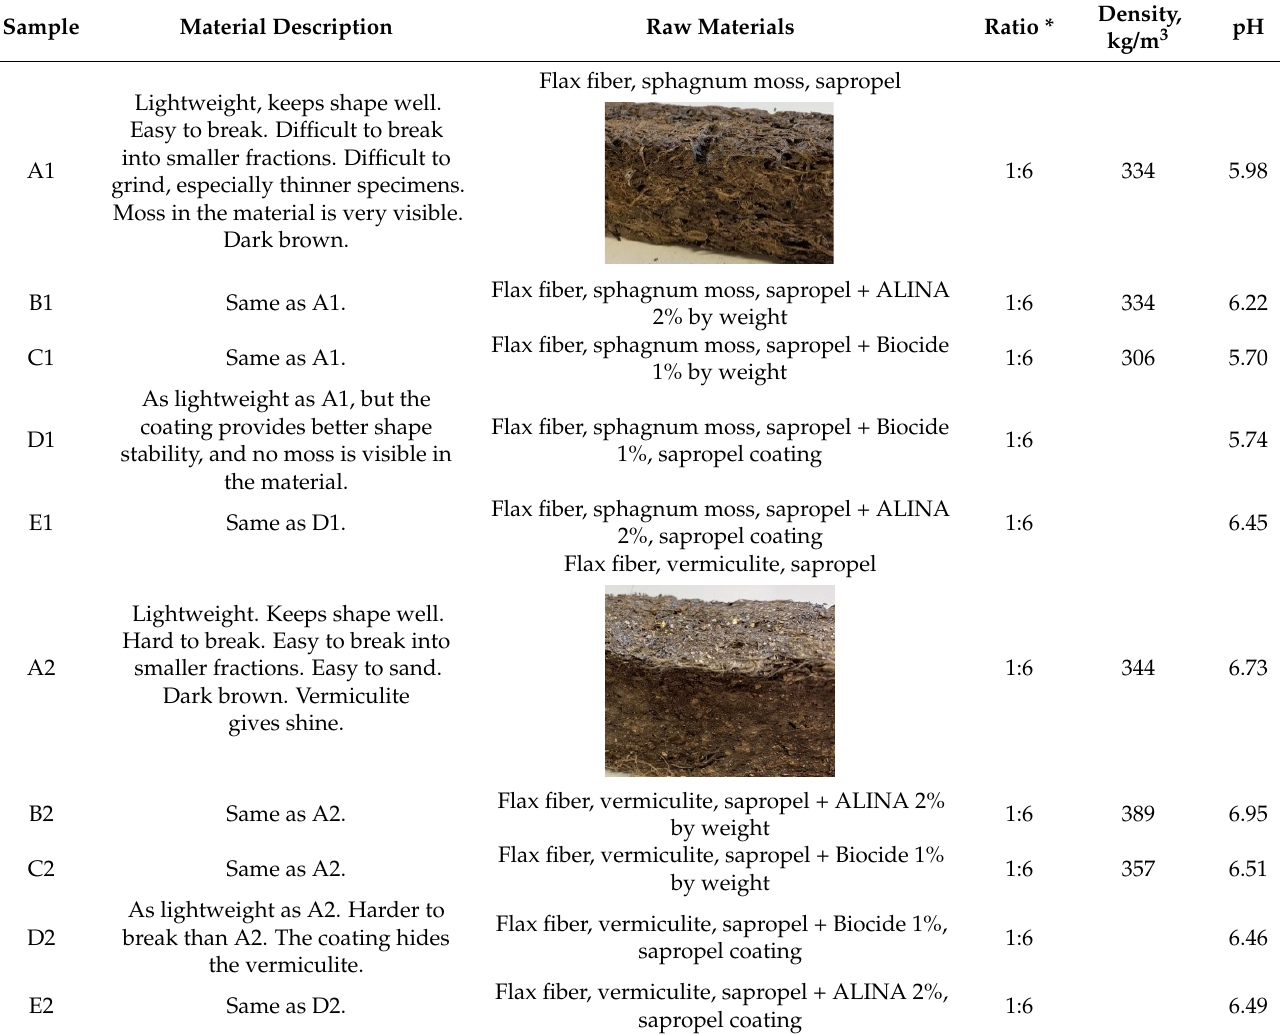
Table 5. Characteristics of composite materials.